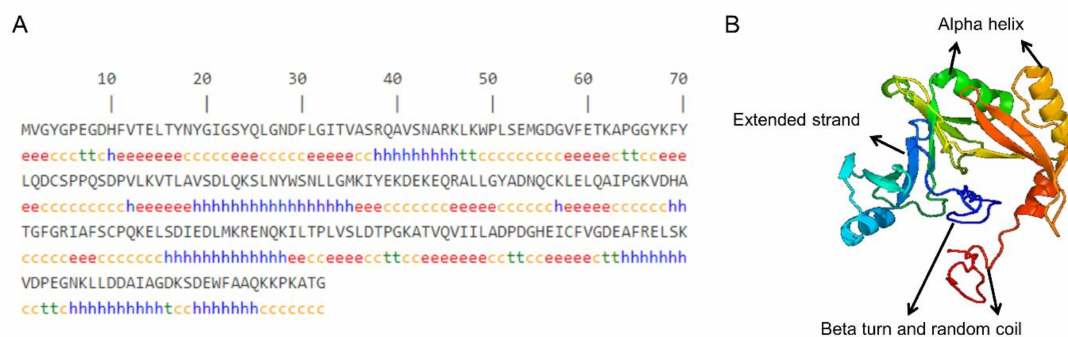
Figure 3. Prediction of structure of the GLOD4 protein. ( A ) Secondary structure of the GLOD4 protein. h (blue), alpha helix; e (red), extended strand; t (green), beta turn; c (yellow), random coil. ( B ) Tertiary structure of the GLOD4